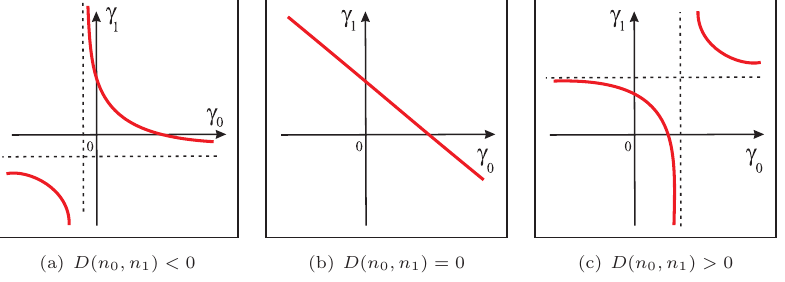
Figure 1. Characteristic Curve for Bitsadze-Samarskii type nonlocal boundary conditions in the case 0 < ξ 0 ,ξ 1 < l .